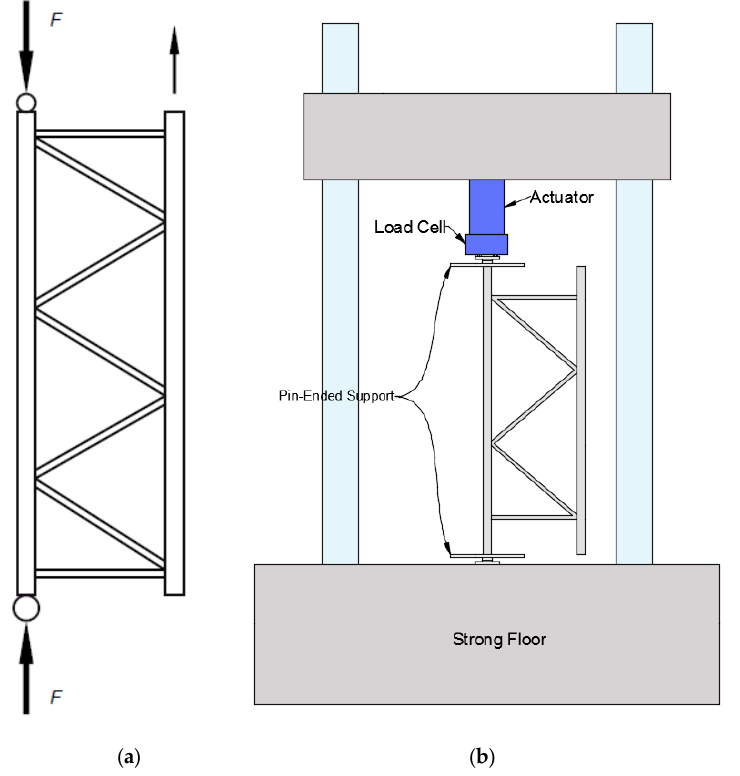
Figure 3. ( a ) Schematic of compressive test on uprights; ( b ) testing